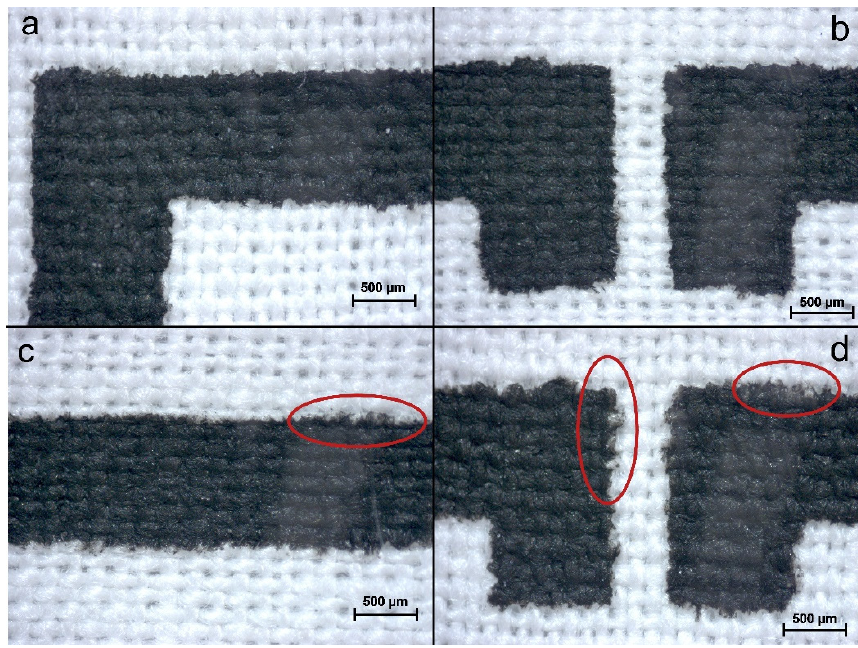
Figure 9. LOOP pattern images: ( a , b ) CNTs/CNC—1:1 ink printed on CO–PES fabric; ( c , d ) CNTs/CNC—0.5:1 printed CO–PES fabric, where red circles pointed out irregularities associated with ink concentration.